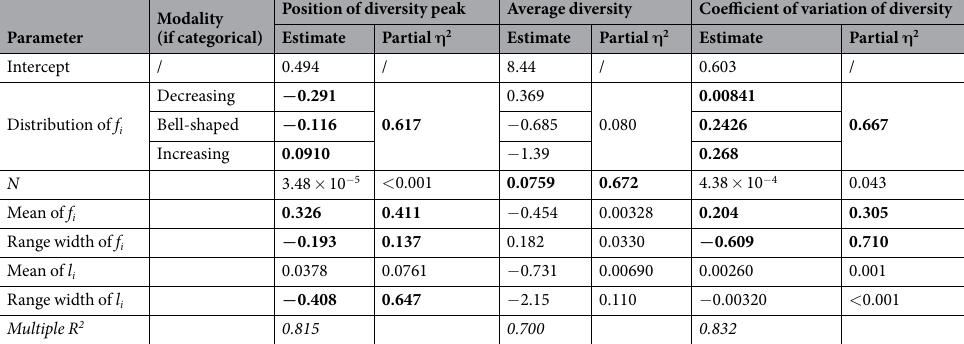
Table 1. Parameter estimates from a linear model linking the position of the diversity peak along the productivity gradient to the structure of the species pool. Estimates and partial η 2 statistics associated with each parameter are displayed. Predictors with partial η 2 > 0.15 are shown in bold and discussed in the main